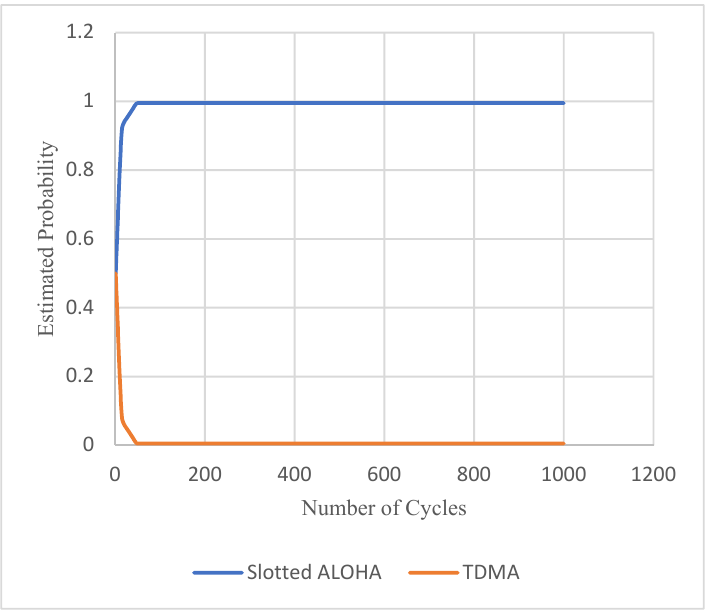
Figure 11. Convergence of automaton estimation of MAC protocol selection probabilities.